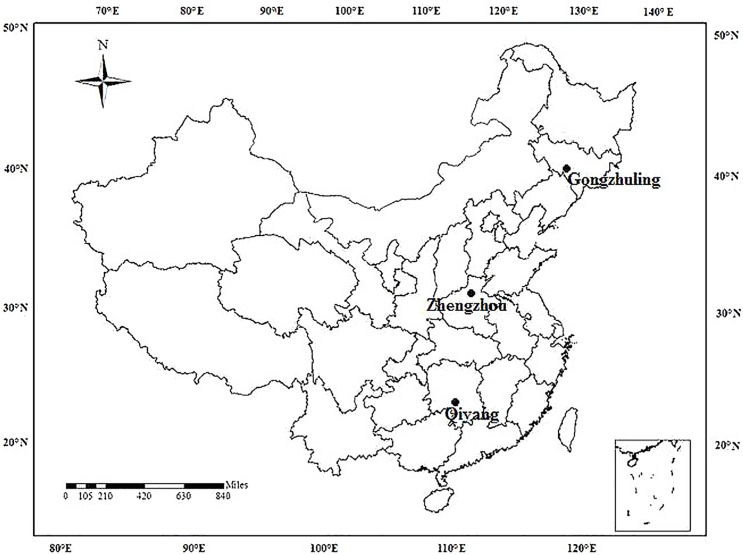
Locations of the three long-term fertilization experimental sites in China.